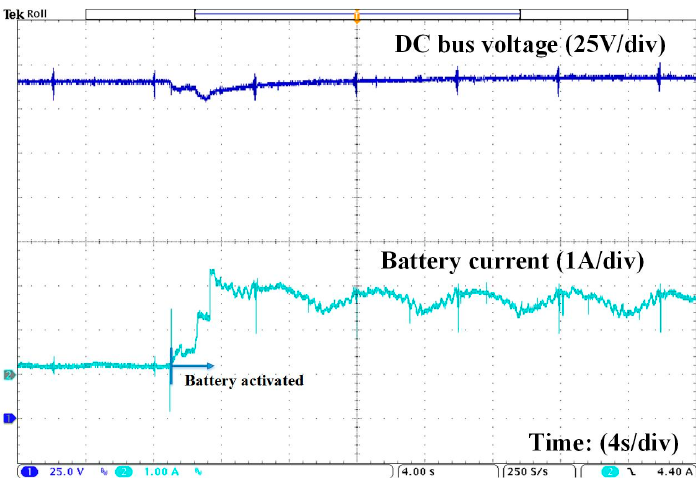
Figure 33. Start of the power supply to the BB.